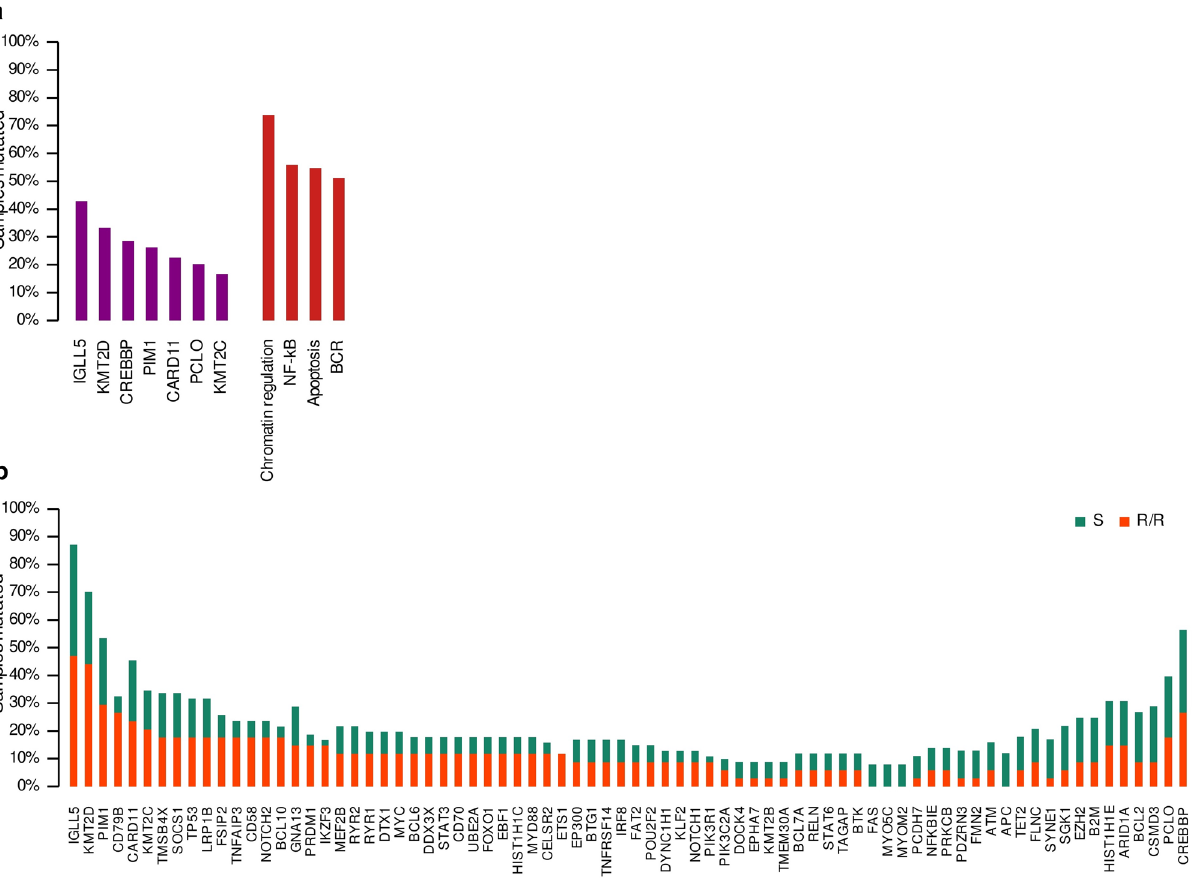
Figure 1. Mutational prevalence in genes and pathways. ( A ) Most frequently mutated genes and pathways in the whole cohort. ( B ) Mutational prevalence for refractory/relapsed (R/R) and sensitive (S) cases for genes with more than four samples